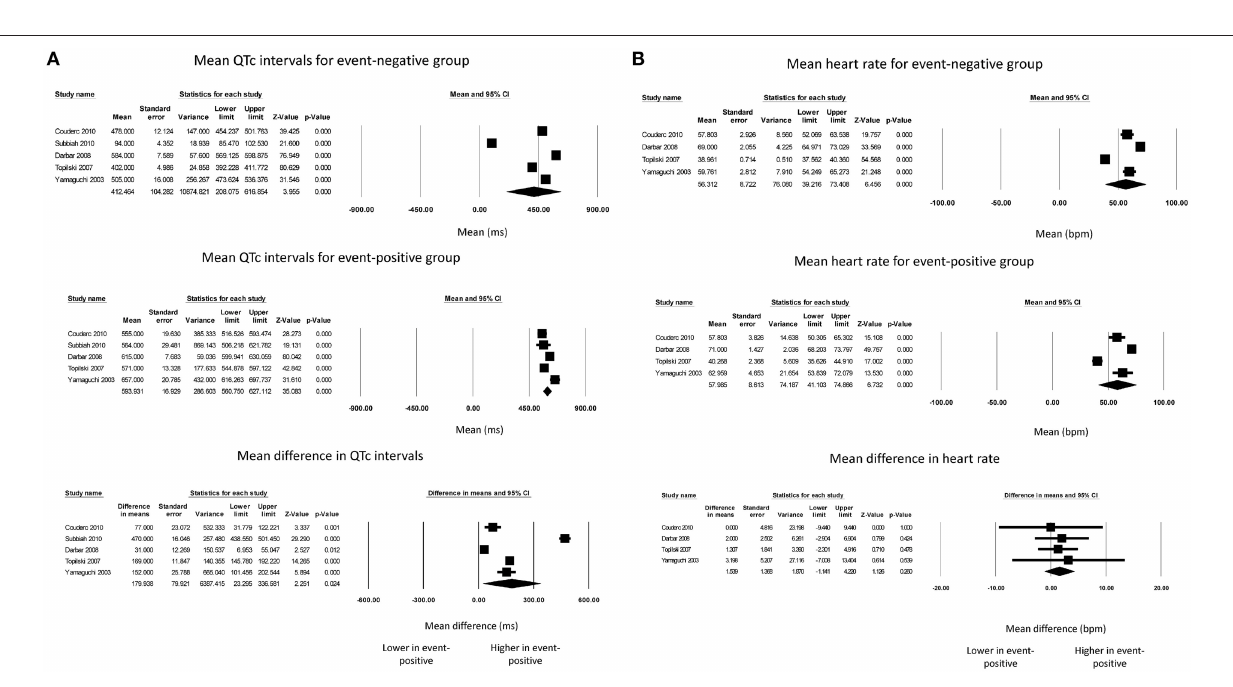
FIGURE 4 | Forest plot demonstrating the (A) mean QTc intervals in the event-negative group (top panel), event-positive group (middle panel) and difference between both groups (bottom panel) in acquired QT prolongation, and (B) mean heart rate in the event-negative group (top panel), event-positive group (middle panel) and difference between both groups (bottom panel) in acquired QT